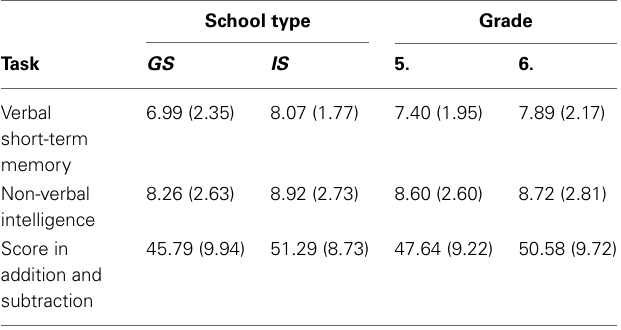
Table A1 | Means (SD in parenthesis) of control variables for general (GS) and intermediate (IS) secondary schools and fifth and sixth grade.